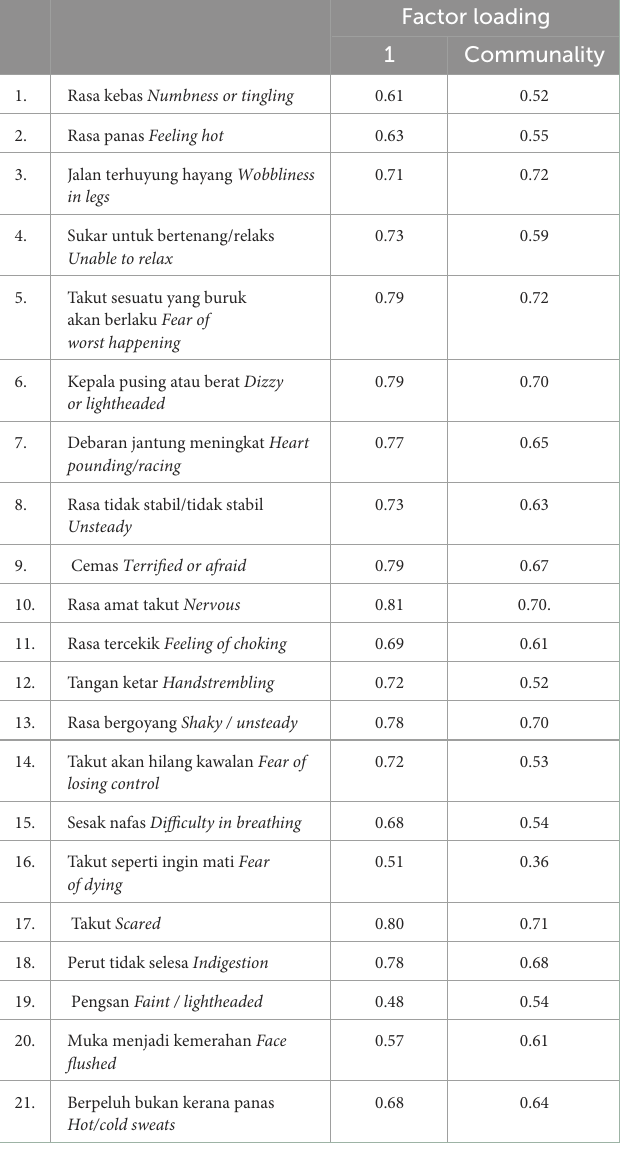
the 21-item BAI ( N = 329). Factor